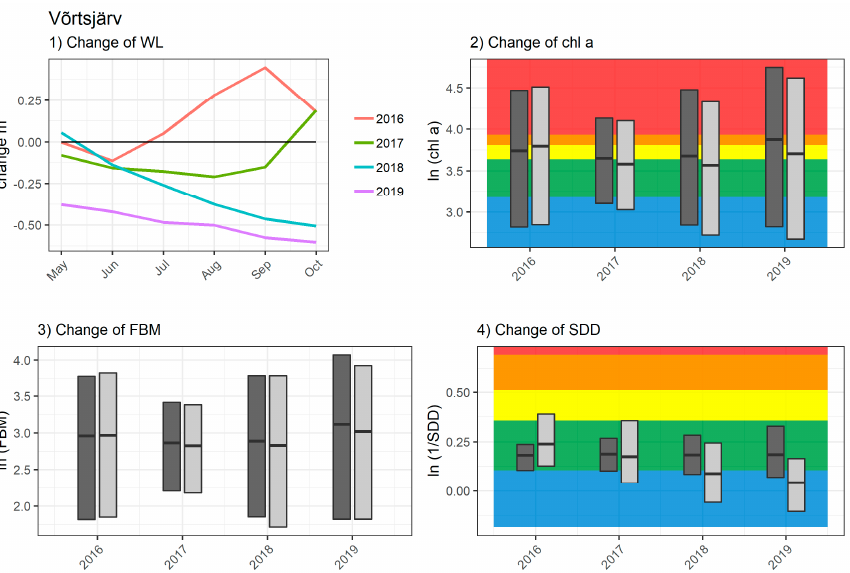
Figure 5. Water level change from long-term monthly mean WL during study period in Võrtsjärv ( 1 ). Value 0 indicates long-term monthly mean WL. Mean, maximum and minimum values of EO-derived WQ parameters are represented on the graphs ( 2 – 4 ), where dark gray indicates values before and light gray indicates values after applying WL correction. Different colors represent ecological status classes according to EU WFD.